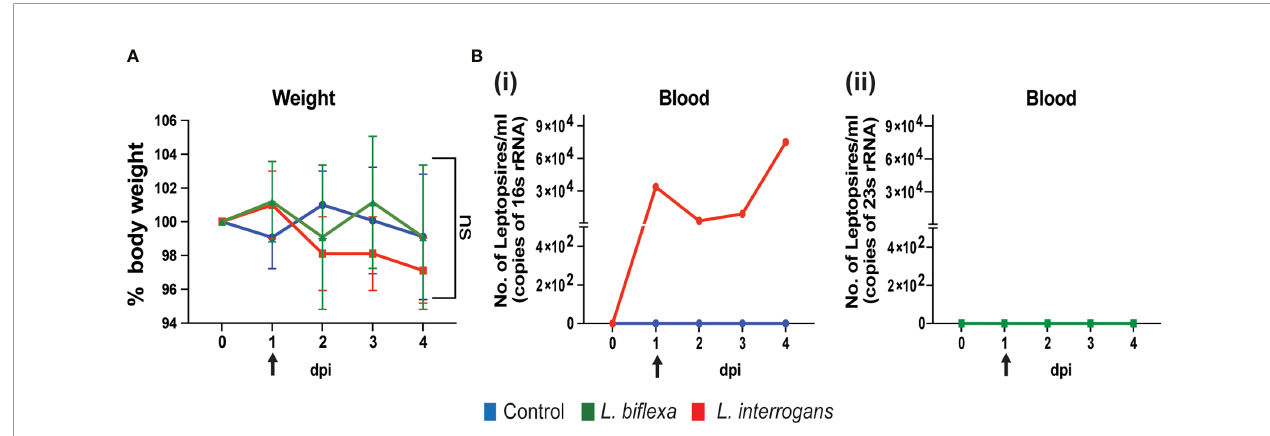
FIGURE 1 | Body weight and dissemination of Leptospira in blood of infected mice. Male C3H-HeJ mice were infected with 10 8 L. interrogans serovar Copenhageni strain Fiocruz L1-130 and L. bi fl exa serovar Patoc whereas control mice received PBS. Panel (A) shows 4-day body weight measurements of mice injected with L. interrogans (red), L. bi fl exa (green), and PBS control (blue). Panel (B) depicts the total Leptospira burden in blood of L. interrogans (i) and L. bi fl exa (ii) infected mice over 4 days post infection by qPCR. n=4 mice per group. Arrow indicates the day of infection. Statistical analysis was performed by unpaired t-test with Welch ’ s correction between control and infected groups. ns, non-signi fi